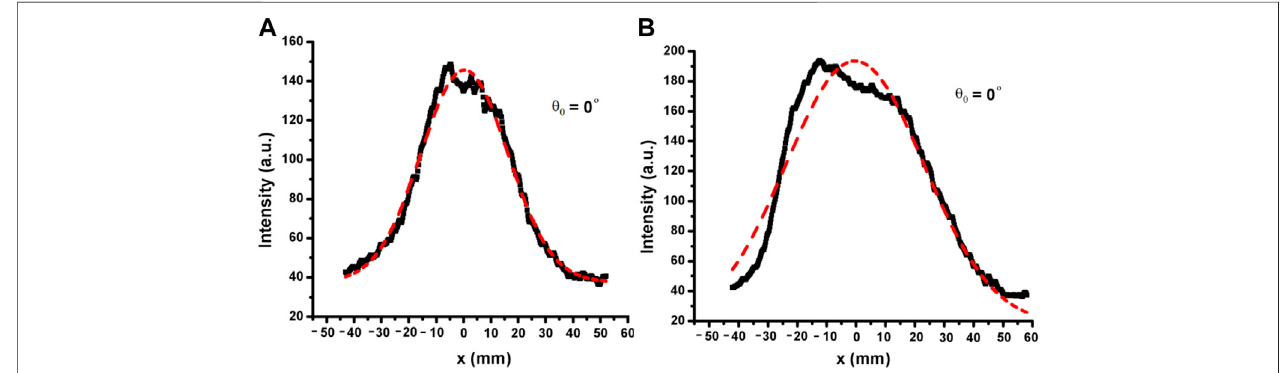
FIGURE 2 | The measured FF pattern from (A) ~1 m and (B) ~19 m PMMA SI MM POF lengths. The light was launched at θ 0 = 0 o [31].